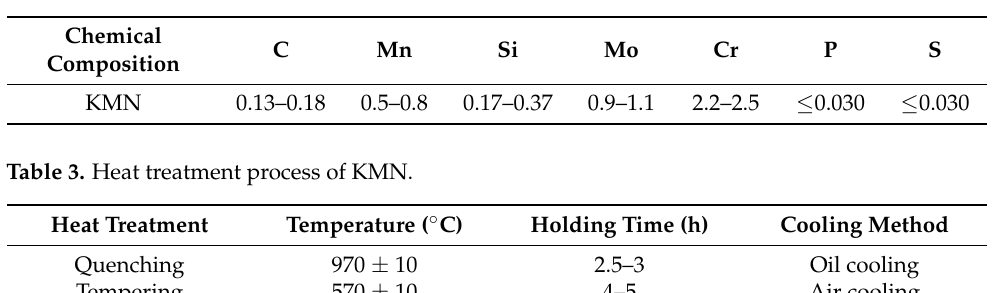
Table 2. Chemical composition of KMN (wt.%).